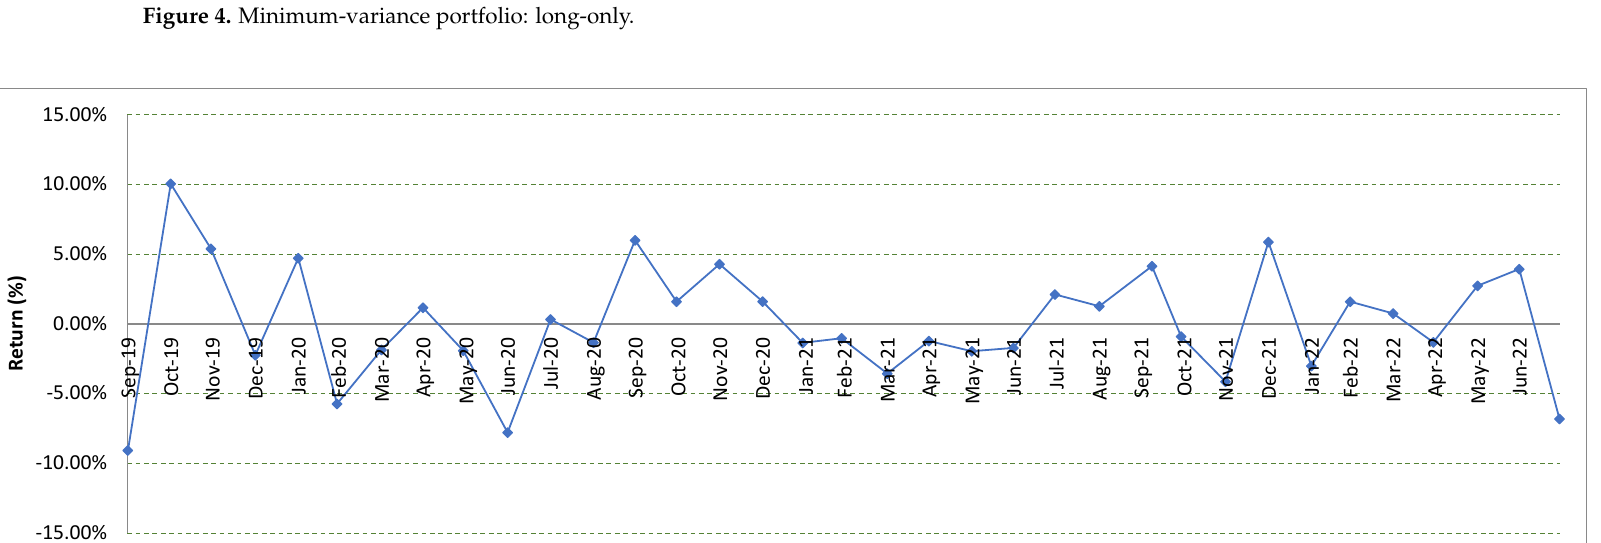
Figure 5. Utility-maximized portfolio ( A = 10): long-only.